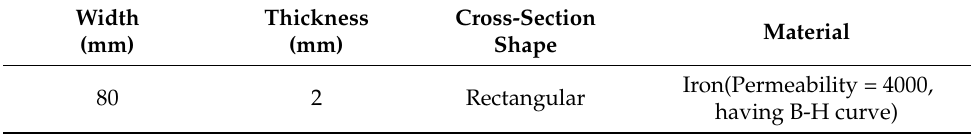
Table 2. Dimension and properties of the conductive sample.